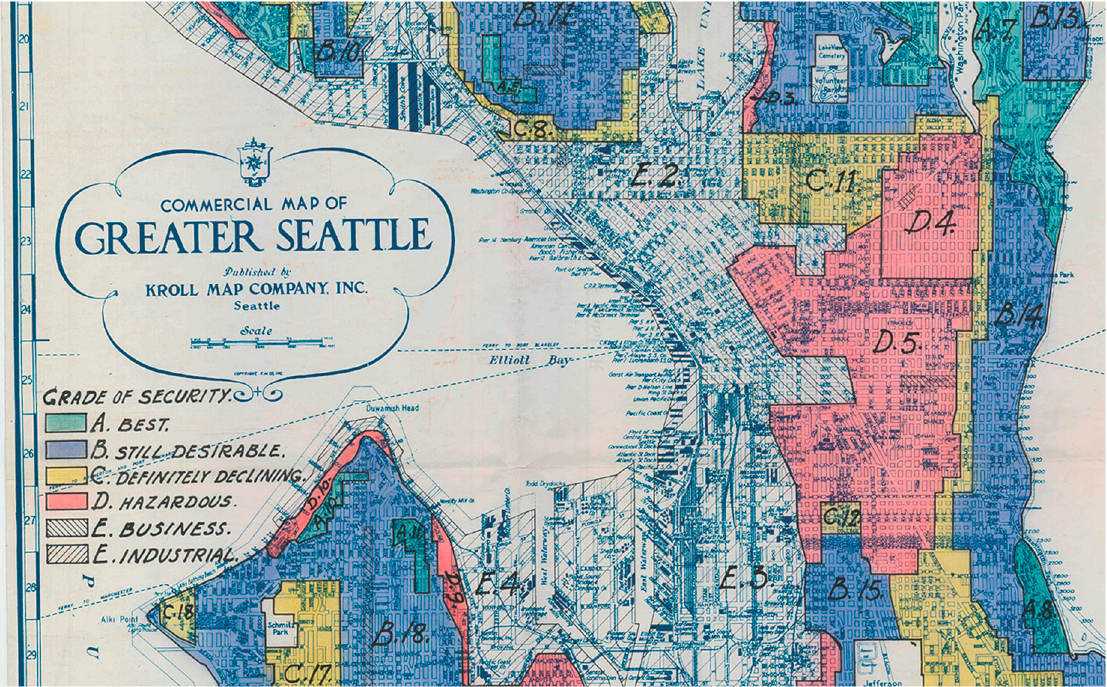
Figure 1. Redlining map of Central Seattle. The Central District includes D4 and D5. Source: Mapping Inequality. (https://dsl.richmond.edu/panorama/redlining/#loc=11/47.594/-122.493&city=seattle-wa).